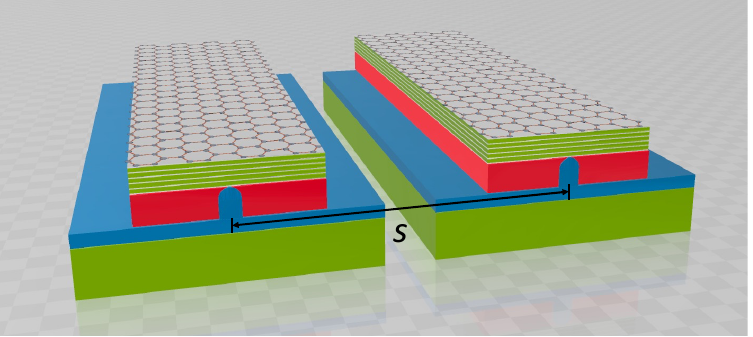
Figure 13. Schematic of a coupled waveguide consisting of two parallel MLGHPWs with a center-to-center separation s .